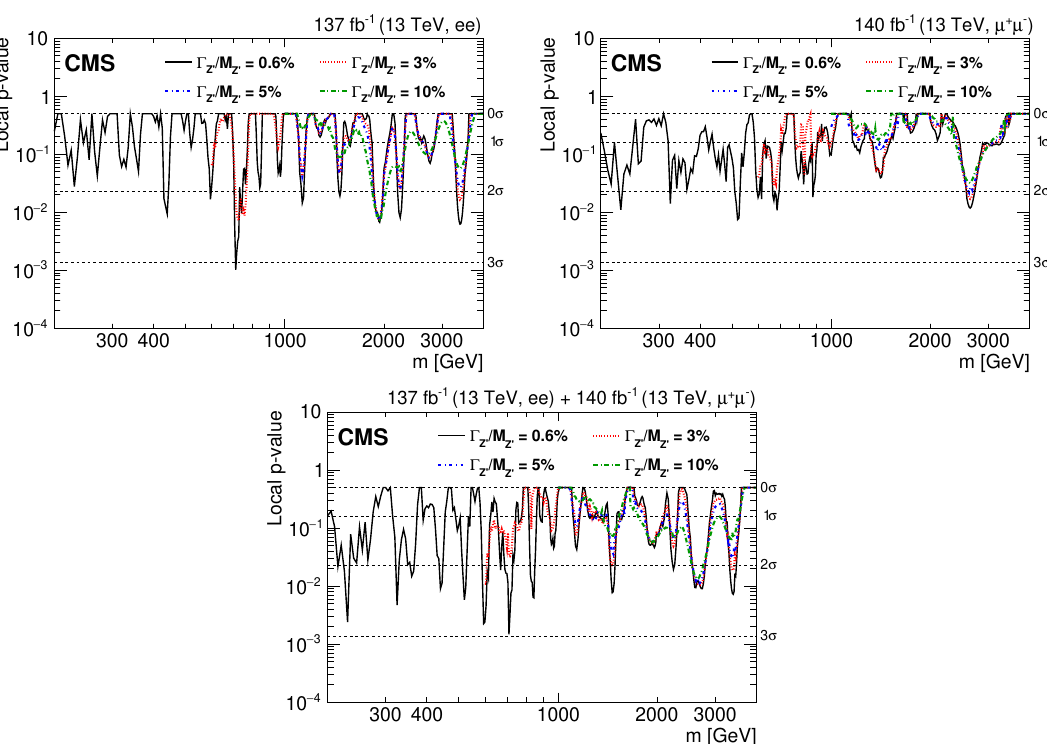
Figure 7 . The observed local p -value for a given resonance mass hypothesis for (upper left) the dielectron channel, (upper right) the dimuon channel, and (lower) their combination, as a function of the dilepton invariant mass. The four different lines correspond to different signal width